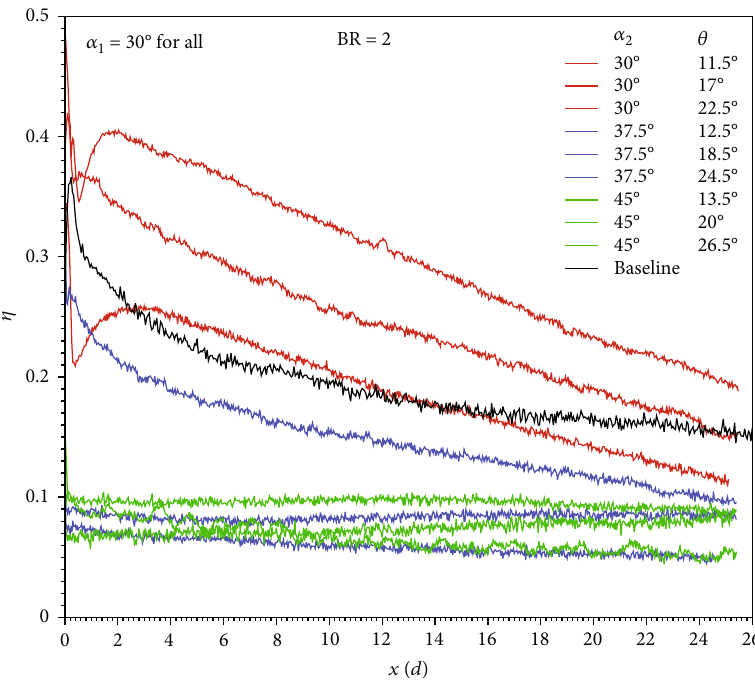
Figure 28: Comparison of streamwise (laterally averaged) fi lm e ff ectiveness variations for all geometries at BR = 2 .